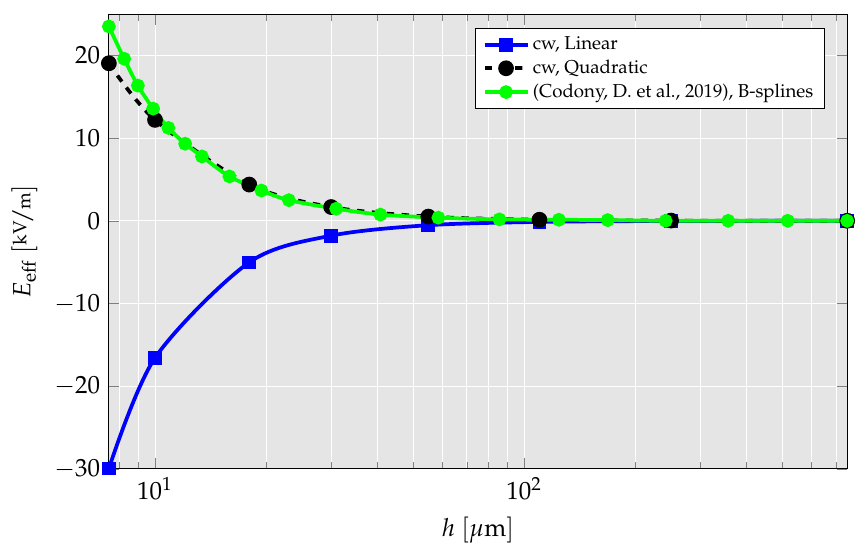
Figure 31. Effective electric field E eff of the truncated pyramid for linear element, quadratic element and [16] for different geometric